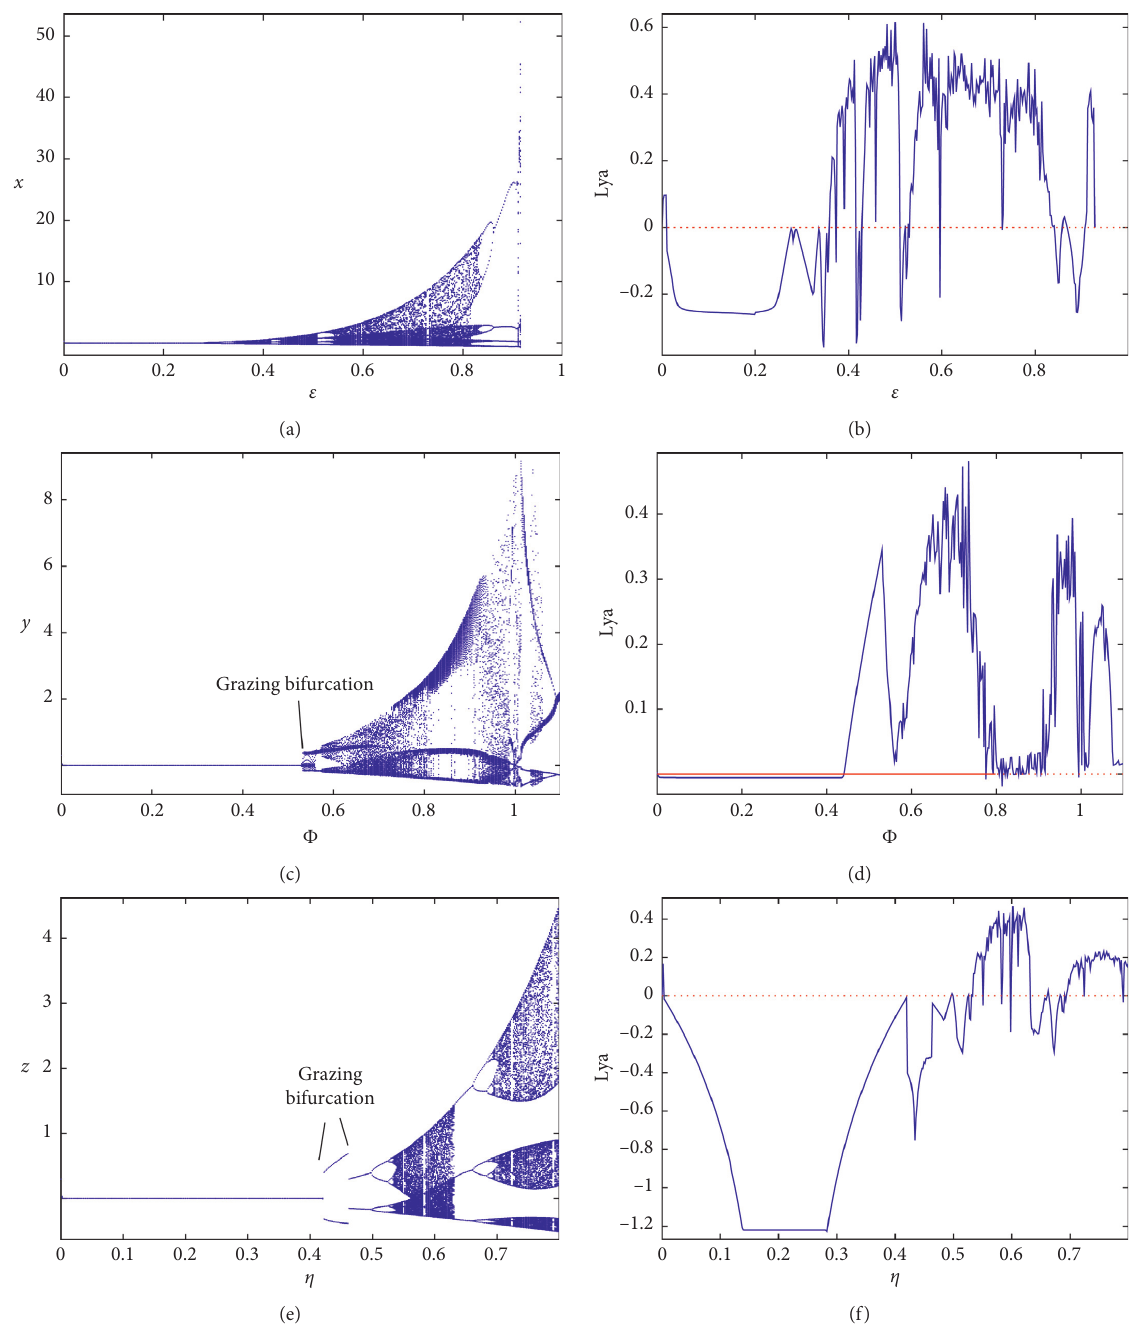
Figure 4: Bifurcation diagrams and Lyapunov exponents. (a) η � 0 . 3 , φ � 0 . 3. (b) η � 0 . 3 , φ � 0 . 3. (c) ε � 0 . 3 , η � 0 . 3. (d) ε � 0 . 3 , η � 0 . 3. (e) ε � 0 . 35 , φ � 0 . 35. (f) ε � 0 . 35 , φ � 0 .